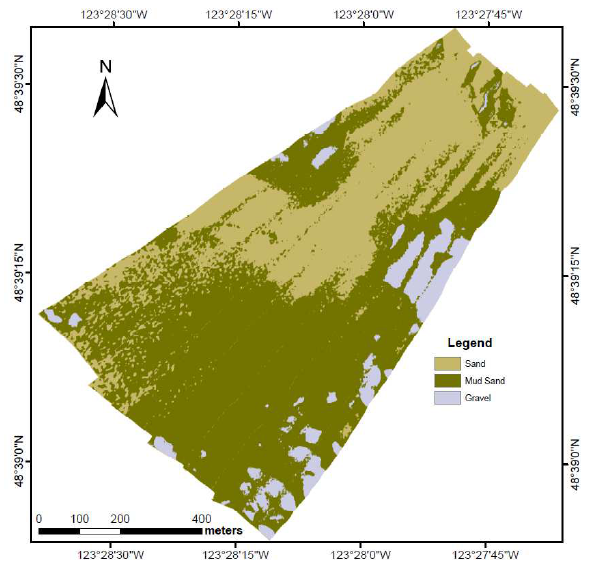
Figure 8: The classification result of Patricia Bay 2016 with three seabed classes. The quantitative evaluation (Table 3) indicated an overall accuracy rate of 98,8%.